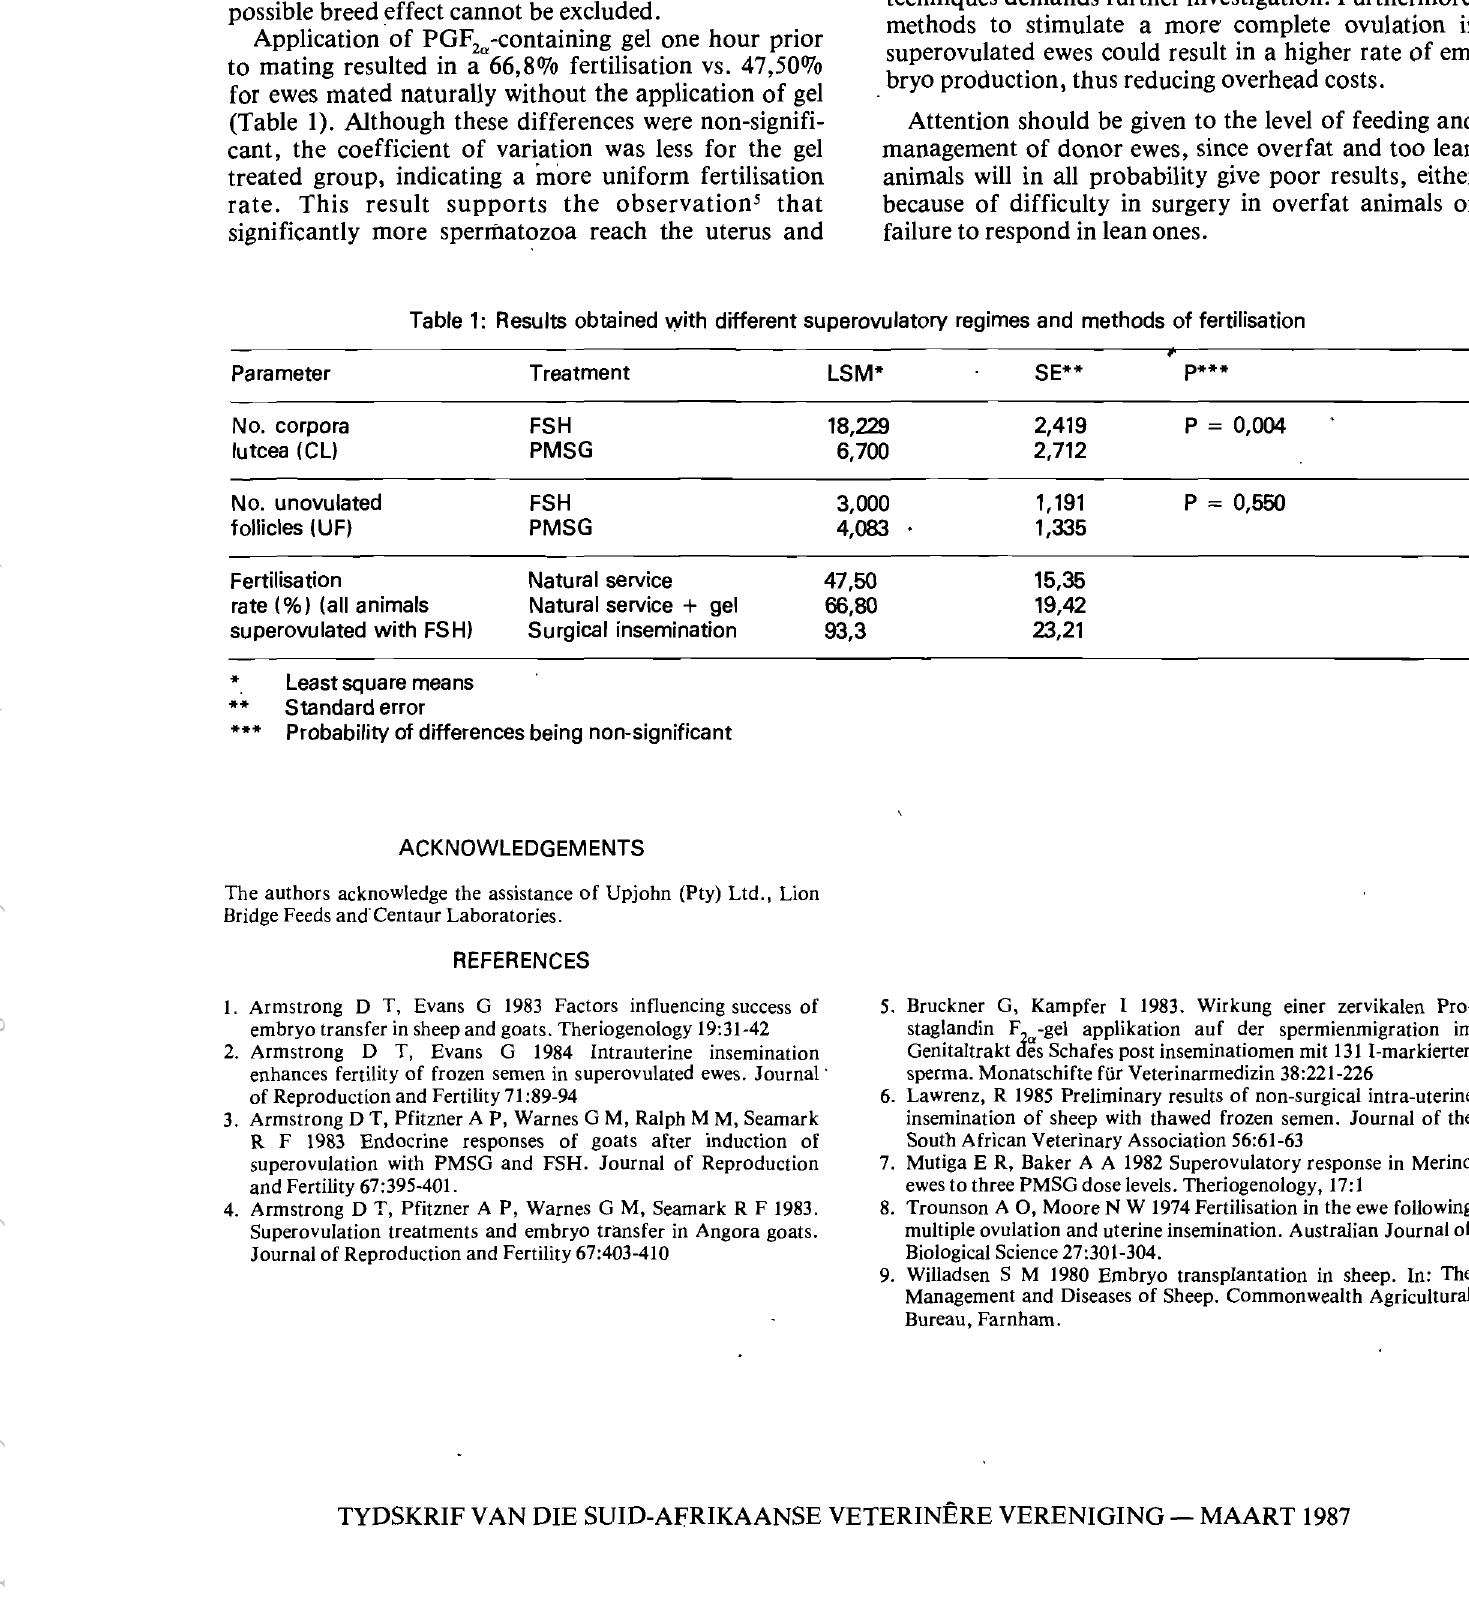
Table 1: Results obtained with different superovulatory regimes and methods of fertilisation